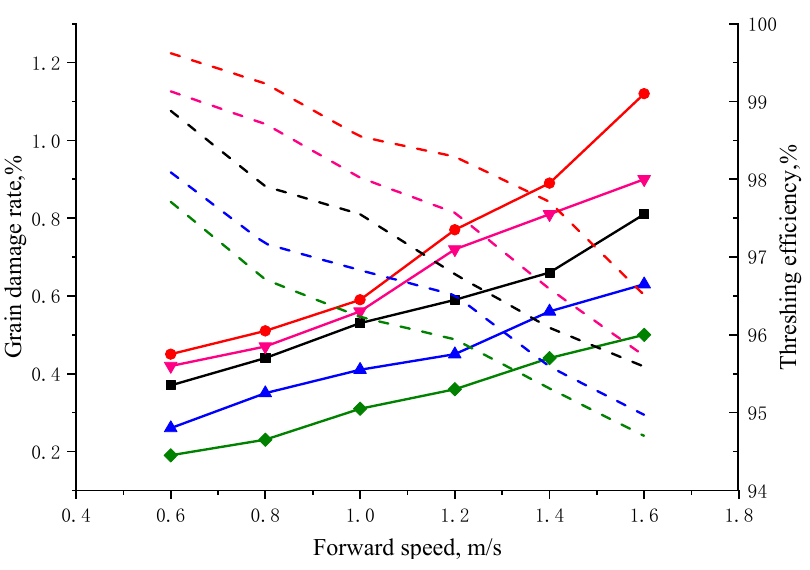
Figure 9. Diagram for the variation of grain damage rate and threshing efficiency at different forward speeds under various threshing gaps, the black --- and - ■ - are initial gap of 20 mm, the red --- and - ● - are threshing drum adjustment type of 10 mm, the blue --- and - ▲ - are concave adjustment type of 30 mm, the pink --- and - ▼ - are concave adjustment type of 10 mm, the green --- and - ♦ - are threshing drum adjustment type of 30 mm.